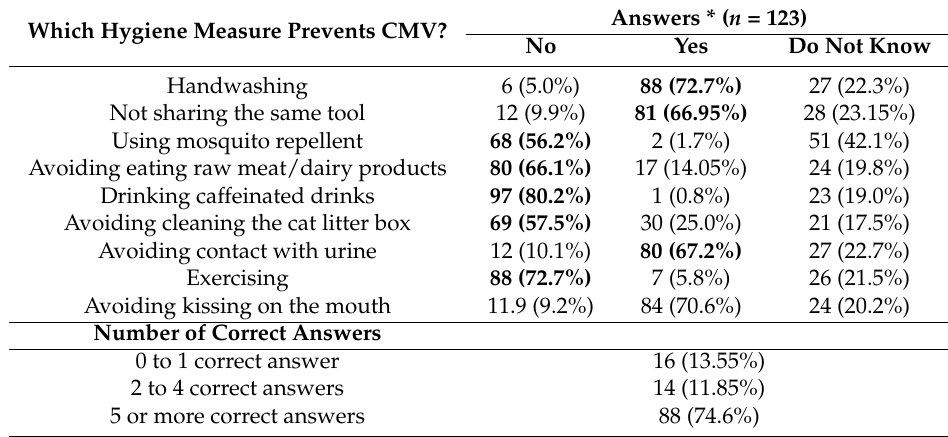
Table 4. Specific knowledge about CMV preventive measures among women who have heard of CMV. Which Hygiene Measure Prevents